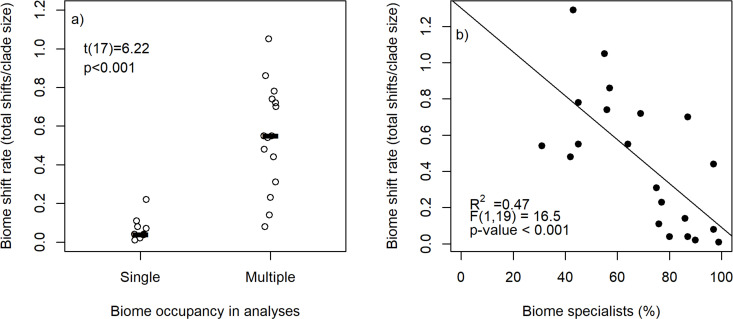
Biome shift rates for clades a) analysed with single or multiple biome occupancy per species approach, and b) by the percentage of species that occur in a single biome. Each point represents a clade in a published study, see Table 1 for information on each clade. Black rectangles indicate the median biome shift rate across all studies. The t-test results are for a one-tailed test comparing biome shift rates in studies that utilised a single biome occupancy approach to studies with analyses that accommodate occurrence in multiple biomes. Model outputs on b) are for a simple linear regression model.